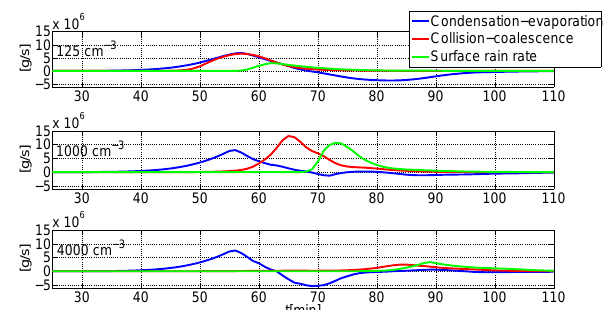
Figure 3. The total condensed–evaporated mass per unit time (blue), the total collected mass per unit time (red) and the surface rain mass (green) as a function of time for three clouds with aerosol levels of 125 (upper panel), 1000 (middle panel), and 4000cm − 3 (lower panel) of profile T1RH1.